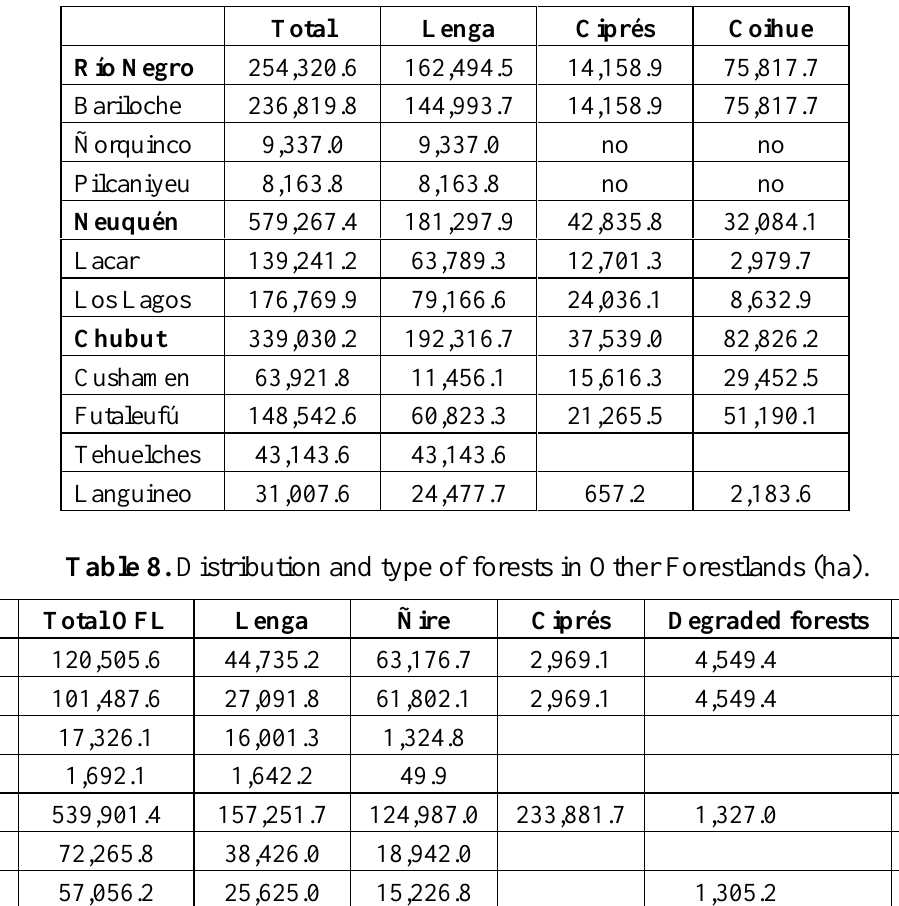
Table 7. Surface of main forests (ha).